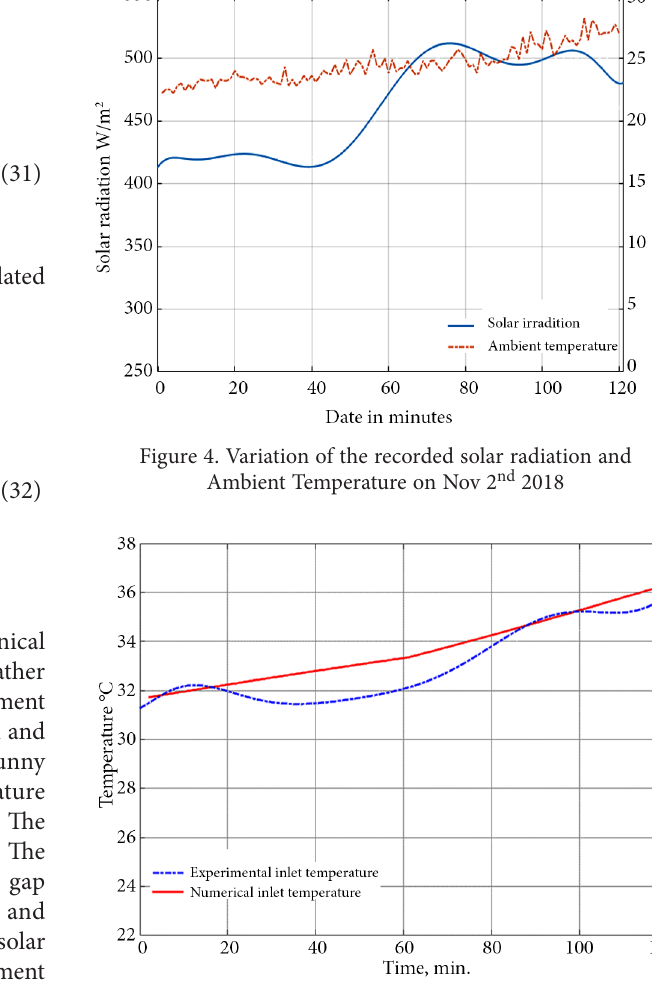
Figure 5. Comparison between numerical and experimental fluid outlet temperatures on Nov. 2018